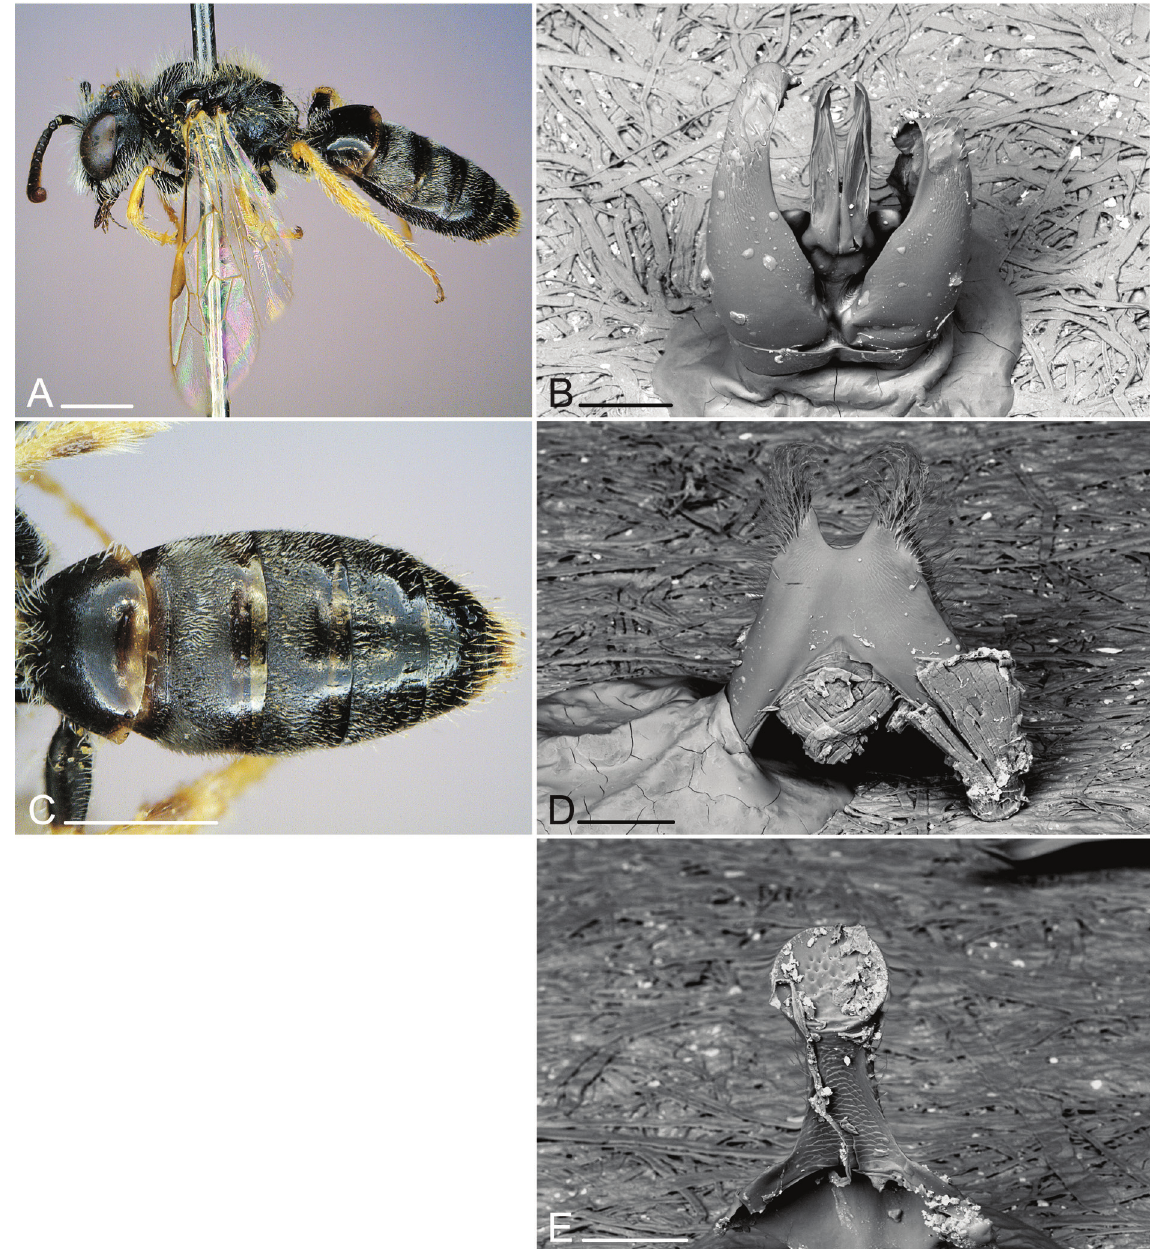
Fig. 9. Scrapter glareus Davies, ♂. A . Lateral view. B . Genitalia (dorsal view, SEM). C . Metasoma (dorsal view). D . S7 (dorsal view, SEM). E . S8, apical end (SEM). Scale bars: photos: 1 mm, SEM: